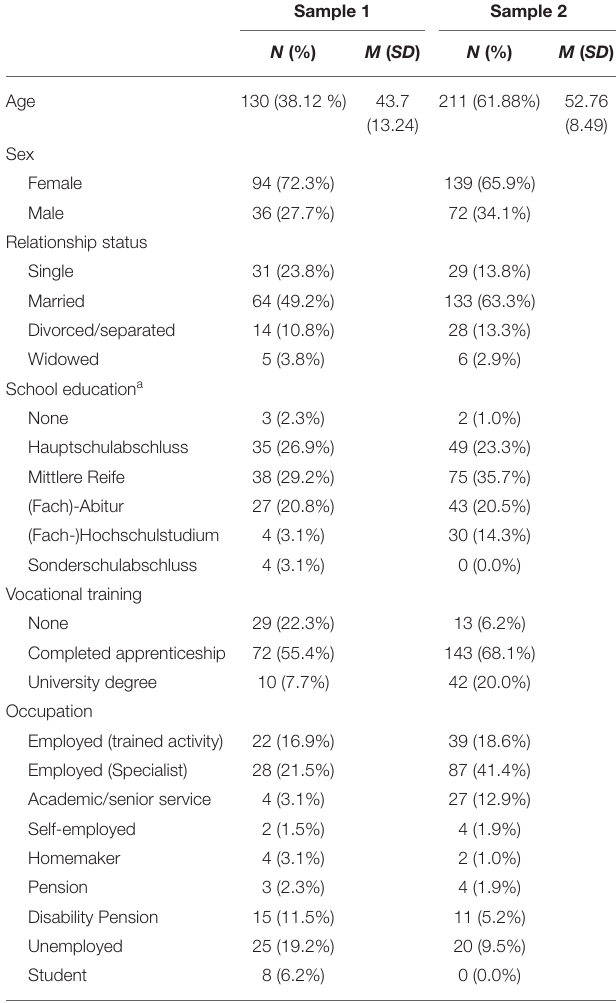
TABLE 1 | Sociodemographic variables separated by